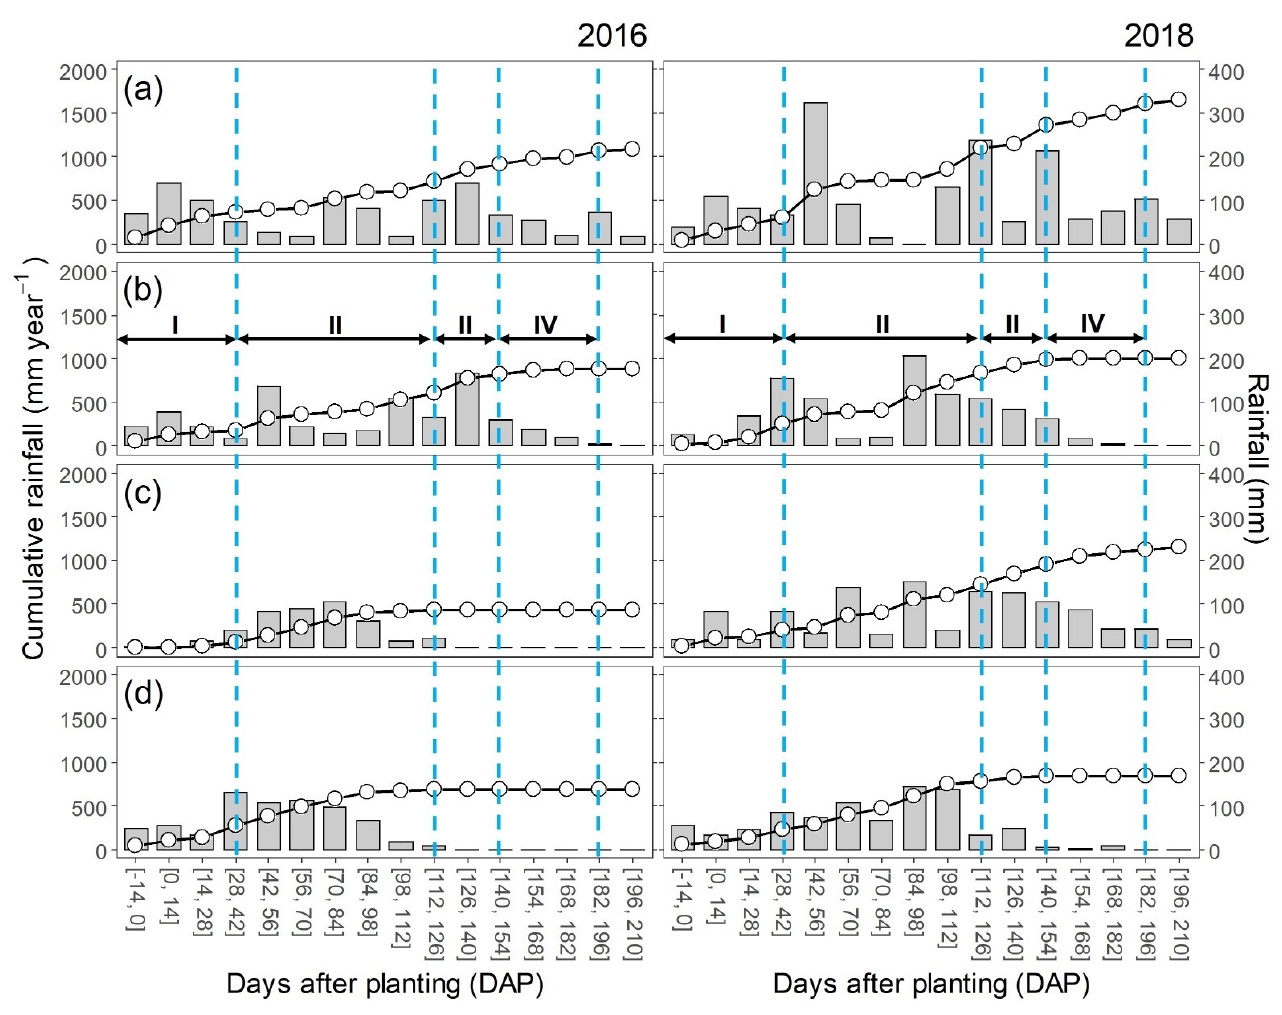
Figure 1. Rainfall recorded every two weeks (columns) and cumulative rainfall (lines) in Liliyo ( a ) and Tiéningboué ( b ), both located in Côte d’Ivoire, and in Midebdo ( c ) and Léo ( d ), both located